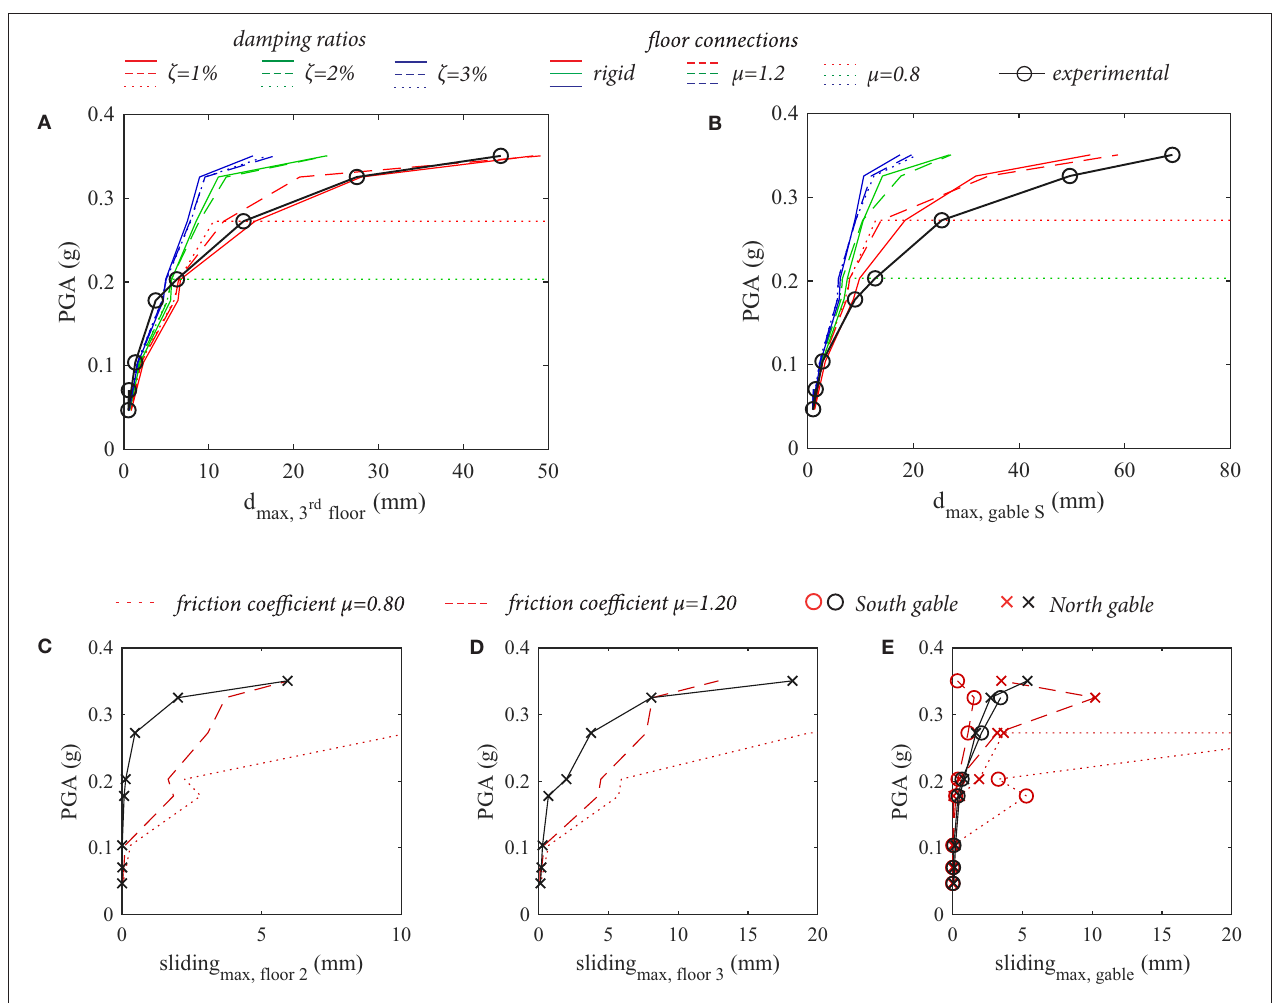
FIGURE 6 | Stone masonry building: estimates of global response quantities with models featuring rigid floor-to-wall connections or nonlinear connections. (A) Third-floor maximum displacement, (B) gable maximum displacement, sliding between diaphragms, and walls for ζ = 1 % at the second (C) and third (D) floor, and between the roof and the gable (E)